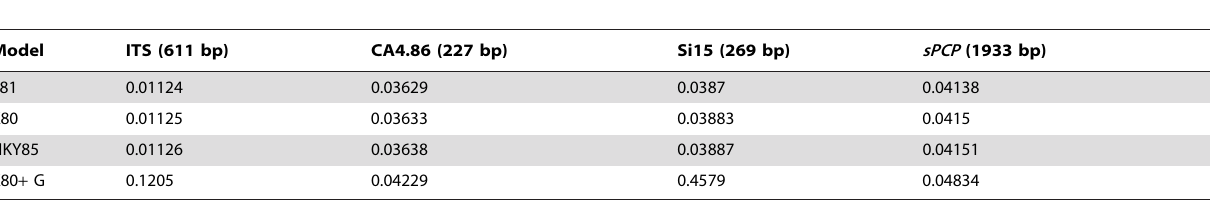
Table 2. Average pair-wise distances of Symbiodinium Clade B nuclear ITS1-5.8S-ITS2, CA4.86, Si15 and long sPCP sequences.